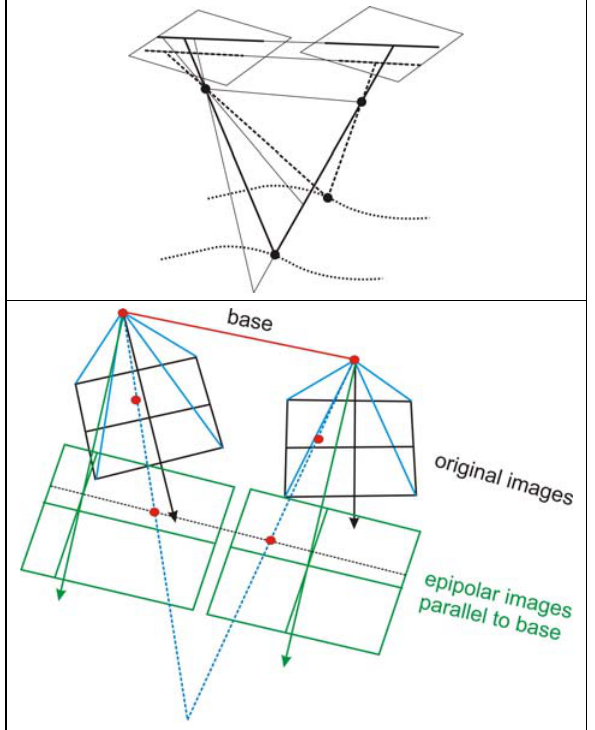
3. EPIPOLAR IMAGES Figure 3: Upper: epipolar geometry, lower: epipolar